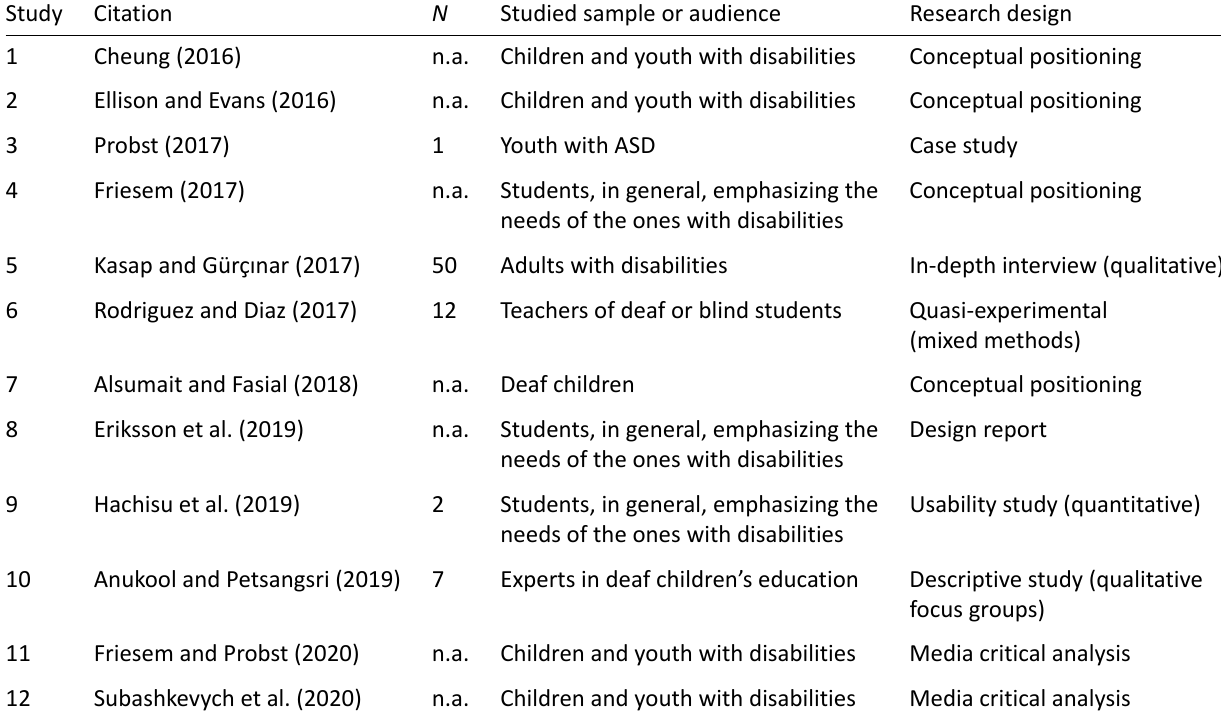
Table 2. Studies’ characteristics regarding the sample and the adopted research design ( N =